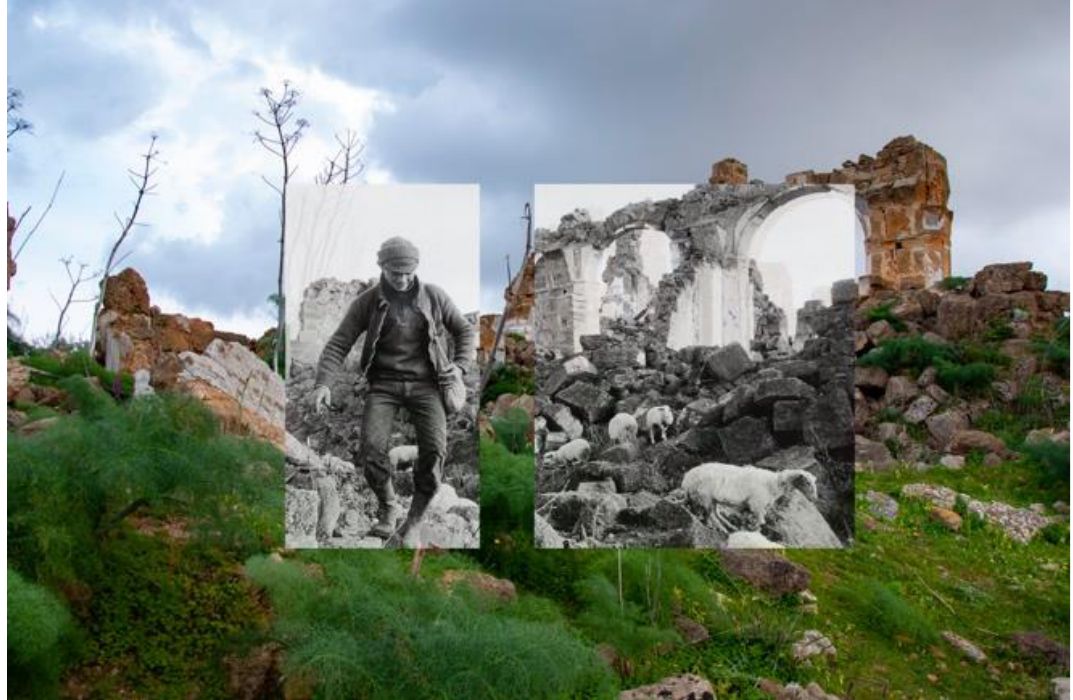
Figure 18. Montevago, 14 January 1985 (Photo: Archivio de L’Ora, Biblioteca Regionale Siciliana “Alberto Bombace”, Palermo) and Ruins of the Chiesa Madre (Photo by the authors, Montevago 2020).